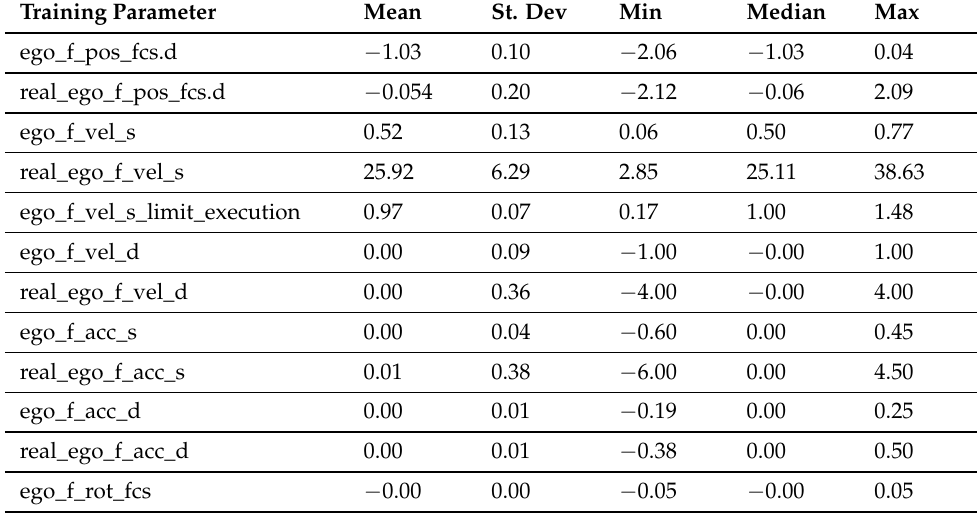
Table 1. Table includes main descriptive statistics for training parameters regarding ego vehicle. Observed real values were normalized within predefined ranges during the creation of input feature vector to the neural